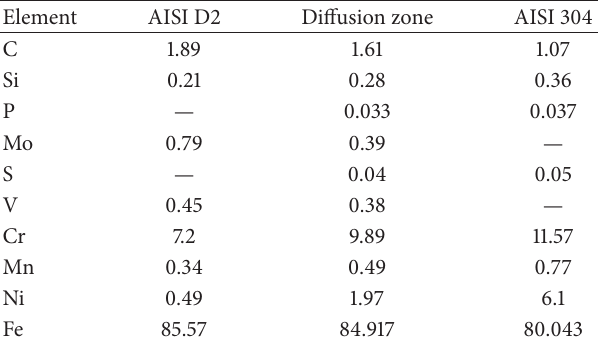
Table 2: EDX analysis and composition of the points marked in Figure